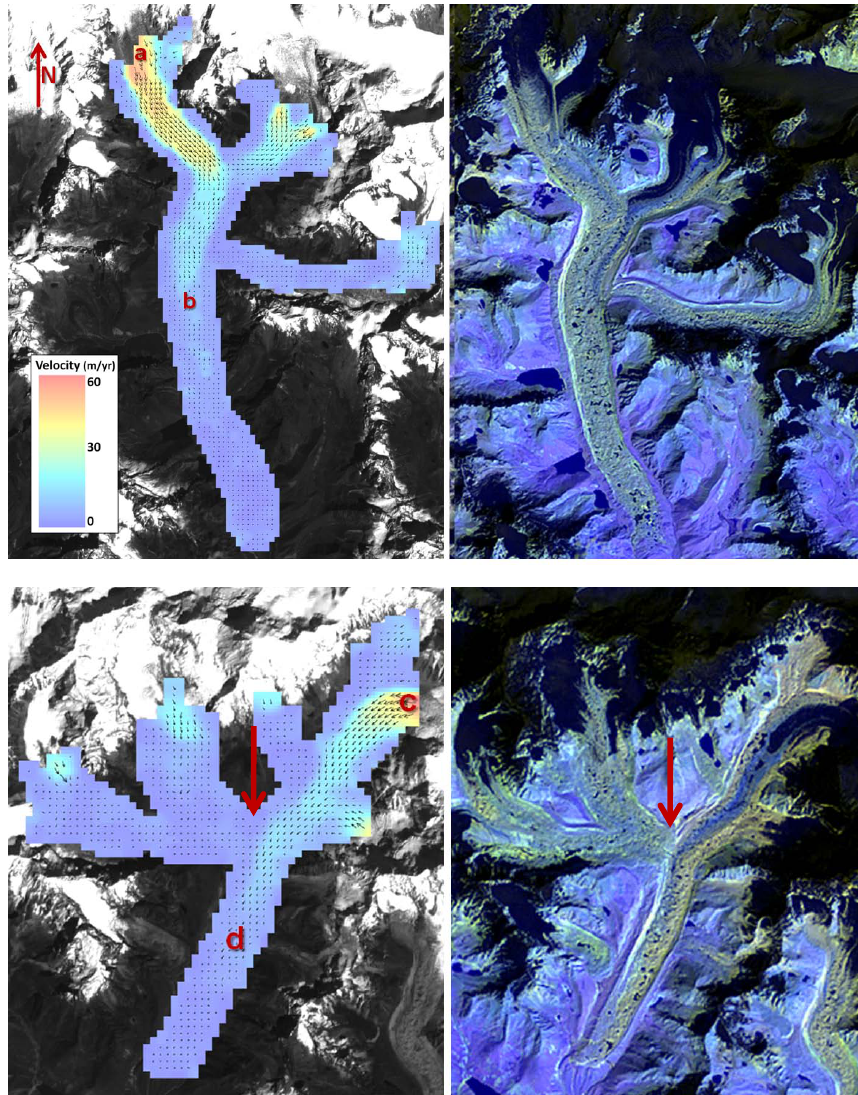
Fig. 9. Ngozumpa (upper image pair) and Khumbu (lower image pair) glacier velocity field (left) and SWIR/TIR false color composites (right) display granitic (yellow) vs. schistic (blue) supraglacial debris flux patterns. Indication of limited mass flux can be seen at the confluence of the Khangri Shar, Khangri Nup and Khumbu glacier (red arrows) by both the distinct change in supraglacial debris mineralogy as well as the low velocities mapped. Theoretical surface particulate flow from “a” to “b” on Ngozumpa glaciers and “c” to “d” on Khumbu glacier, indicate transport times of 380 and 450 years,